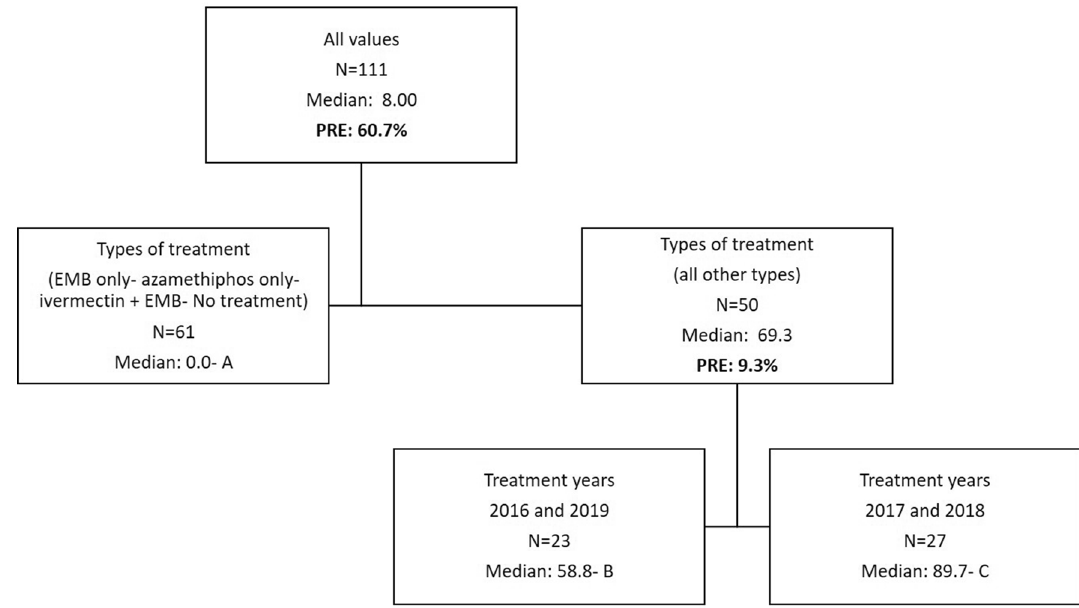
Figure 3. DTA with sums of normalized rates of multi-chemical usage as a dependent variable. Predictors include: Year, Bay, company, usage of lumpfish, numbers of fish, types of treatment, stocking year, and median distance to other sites. The total PRE of this tree is